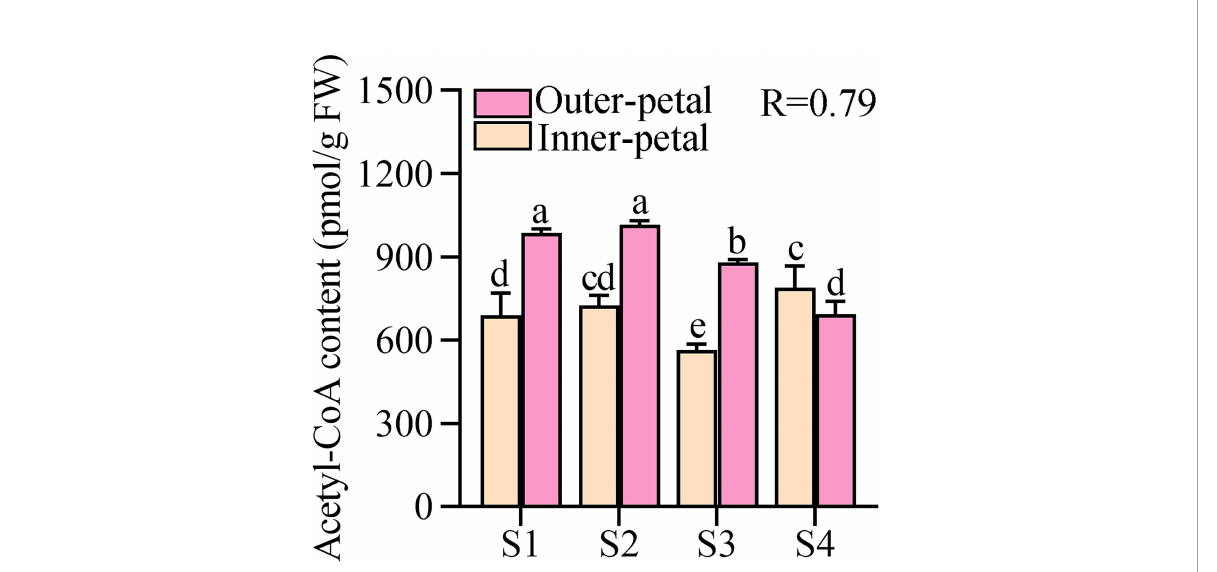
FIGURE 2 Quantitative analysis of acetyl-CoA in P. lacti fl ora red outer-petals and yellow inner-petals from S1 to S4. S1, unfold-petal stage; S2, soft-bud stage; S3, initial- fl owering stage; S4, full- fl owering stage. The values represent the means ± SDs, and different letters indicate signi fi cant differences ( P <